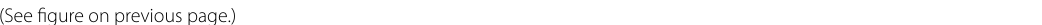
substrate(See figure on previous Fig. 3 Microfabrication results: a cross‑sectional scheme of the FMM‑mimic microstructure, b picture of the fabricated FMM‑mimic microstructure, c SEM images of the top and tilt view position at the corner of a rectangular opening, and d SEM images of the gap between a Si substrate and a glass